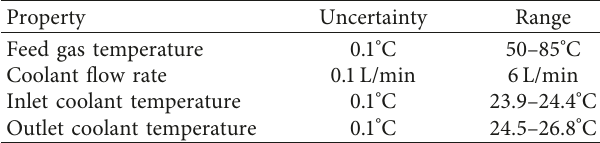
Table 3: Experimental uncertainties.